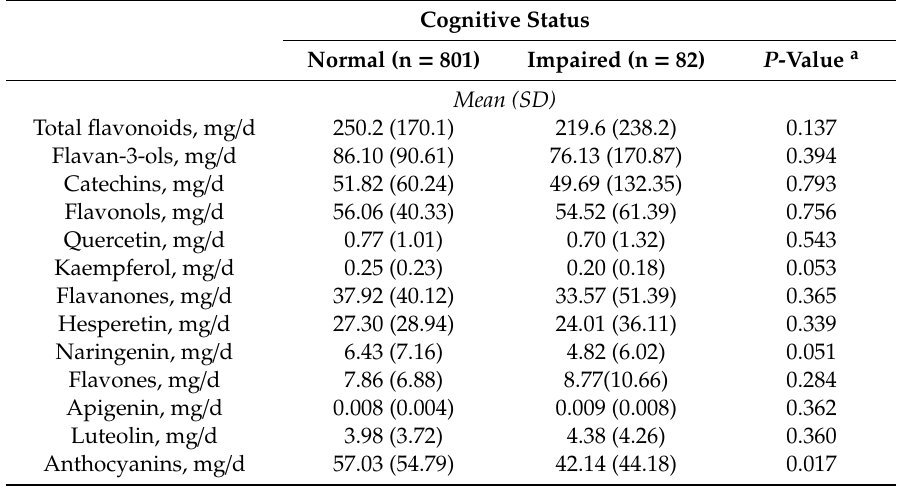
Table 2. Mean intake and standard deviation of total, classes and individual flavonoid by cognitive status in the MEAL